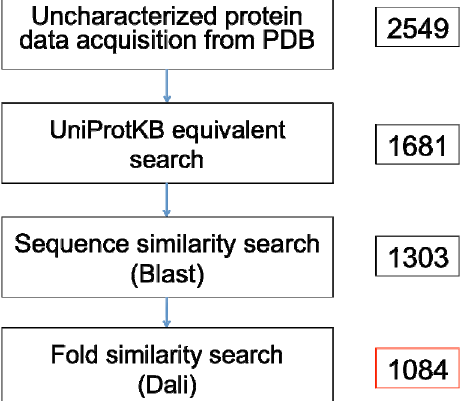
Figure 2. The steps taken to get to a final dataset of 1084 “true” proteins of unknown functions, i.e. , PDB entries that lack a significant degree of functional annotation and possess no detectable sequence or structural homology with any protein of known